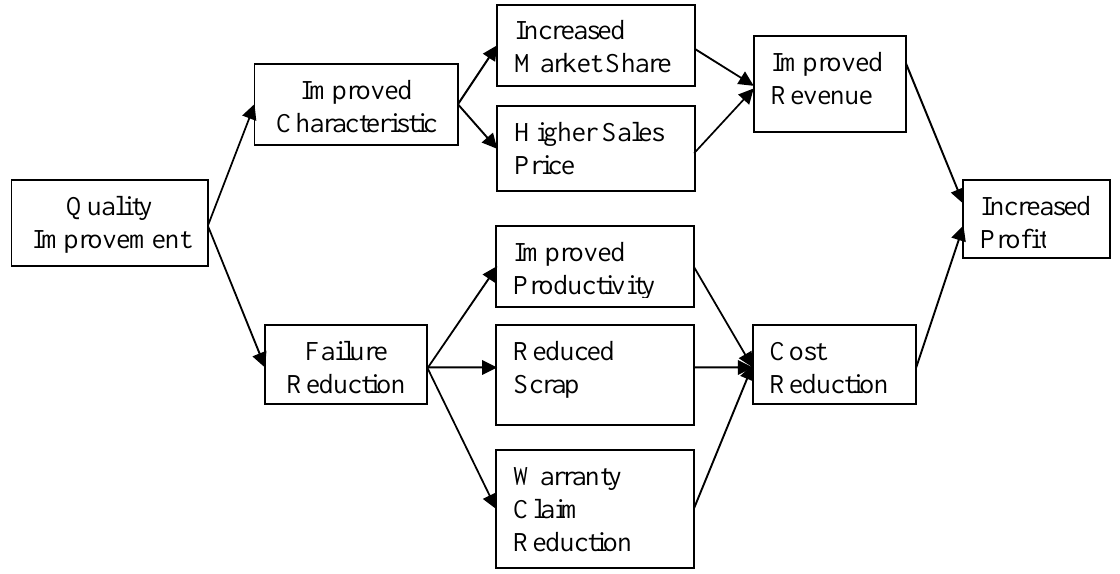
Figure 1 – Economics of a quality improvement project